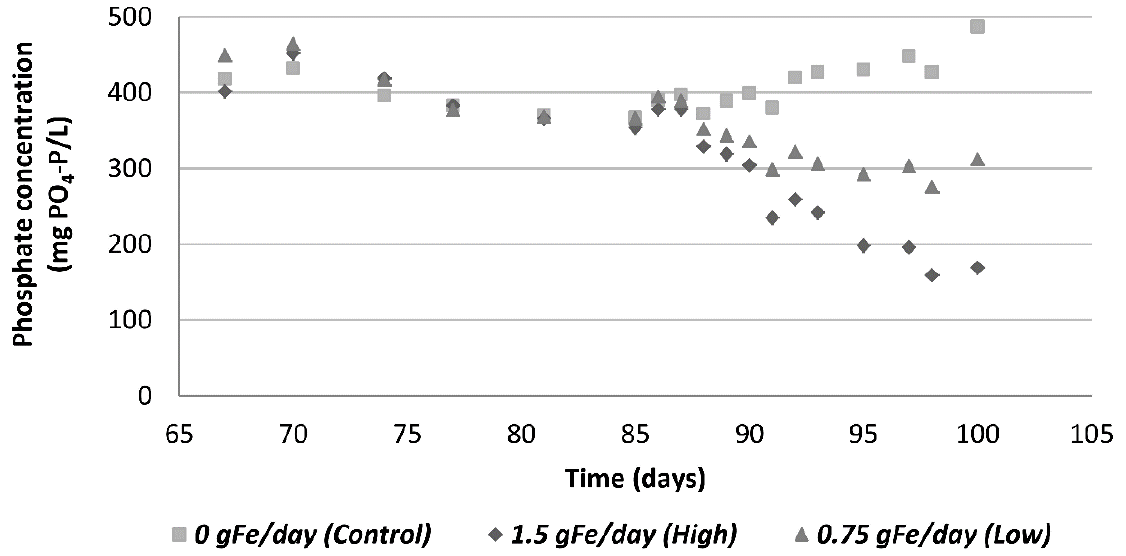
Figure 5. The dissolved phosphate concentrations (as mg PO 4 -P / L) in the continuously operated reactors. The dosing of ochre started on day 85 of the experiment and continued until day 100. The dosage was adjusted to 1.5 g Fe 3 + / day and 0.75 g Fe 3 + / day in the high and low reactors, respectively. No addition of ochre was introduced in the control reactor.